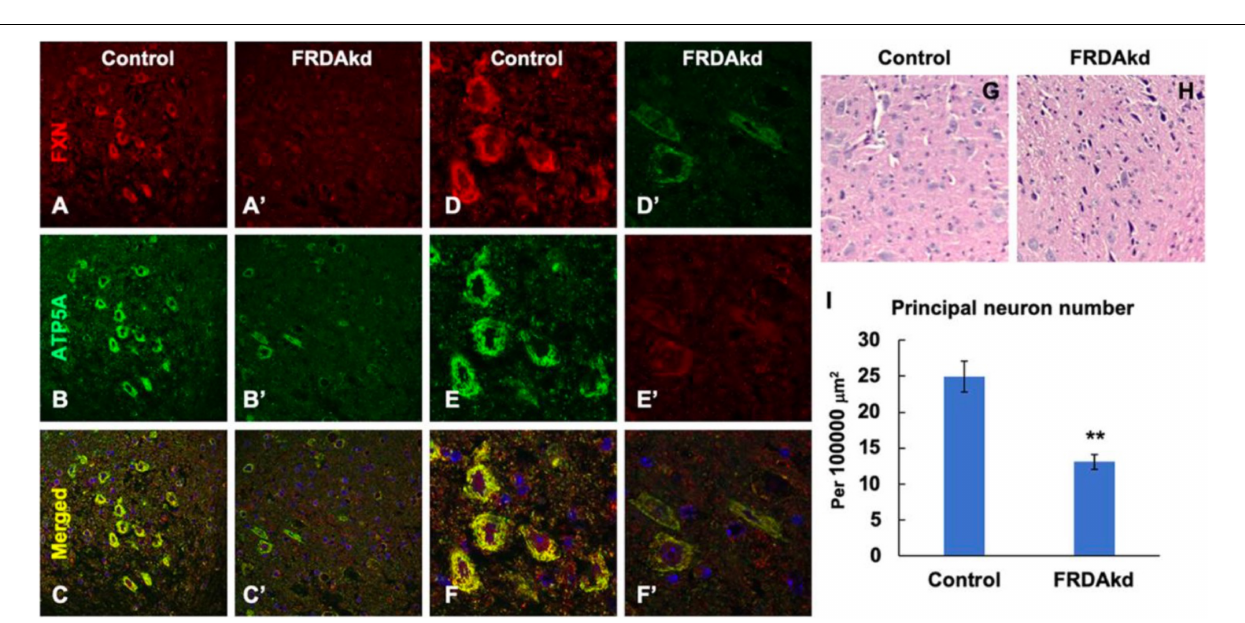
FIGURE 6 | The number of ATP5A-positive-cerebellar Purkinje neurons is decreased in FRDAkd mice at 18 weeks of dox treatment. Confocal images of frataxin (FXN) (red) and mitochondrial marker ATP5A (green) fluorescence, and merged images with DAPI-stained nuclei (blue) in the cerebellum of FRDAkd (A (cid:48) –F (cid:48) ) and control mice (A–F) . Hematoxylin-Eosin staining of cerebellar Purkinje neurons in FRDAkd (H) and control (G) mice. (I) Quantification of ATP5A-positive Purkinje neurons in FRDAkd and control mice at 18 weeks of dox treatment (Stats: n = 3 mice per group, 3 sections per mouse, mean ± SEM, student’s t -test, ** P < 0.01).